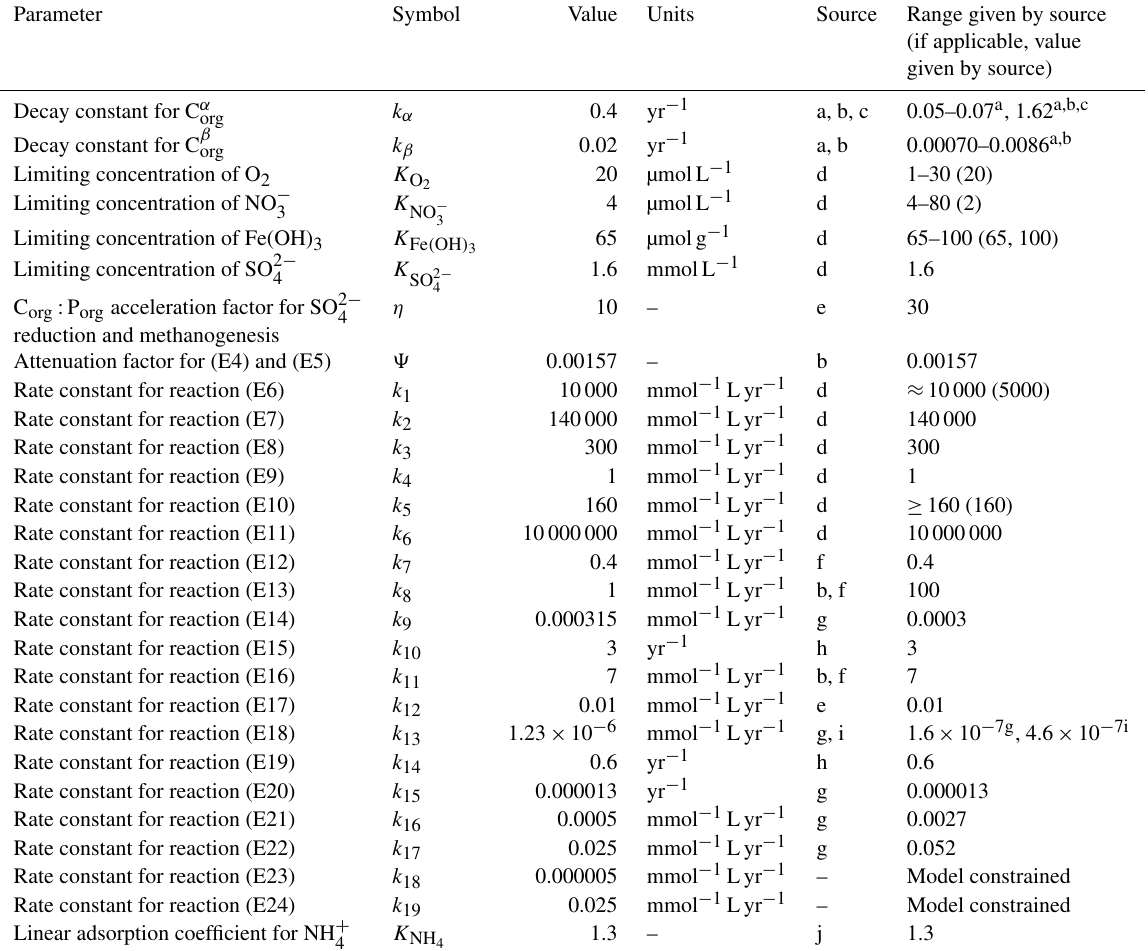
(if applicable, value given by source)